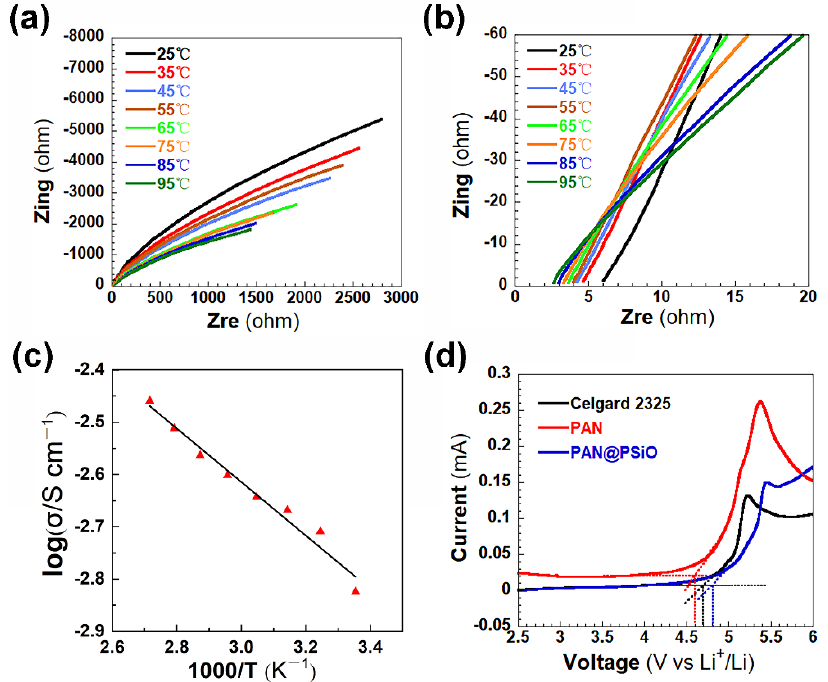
Figure 3. ( a ) The AC impedance spectra and ( b ) plots in the high frequency region of the AC impedance spectra of PAN@PSiO electrolyte membrane at different temperatures; ( c ) temperature dependent ionic conductivity of PAN@PSiO electrolyte membrane; ( d ) LSV of the Celgard 2325, PAN and PAN@PSiO electrolyte membranes.